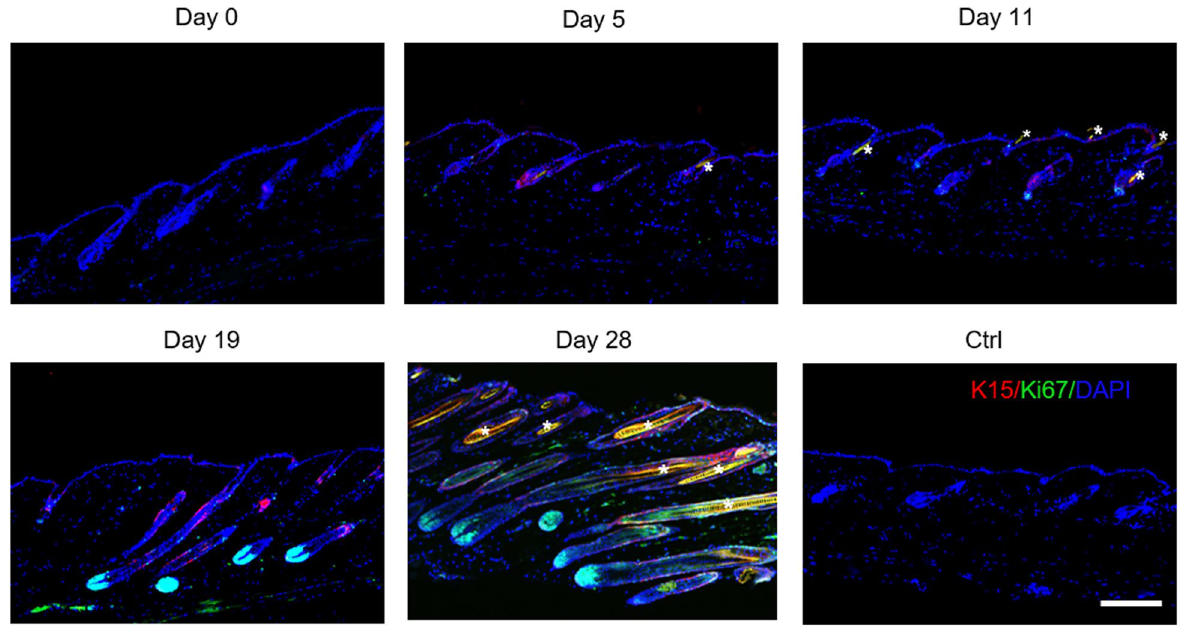
Fig. 5 Hair follicle stem cells activated by MNA treatment. K15/Ki67 double-immunofluorescence staining on days 5, 11, 19 and 28 revealed that the hair follicle stem cells were gradually activated and proliferated after MNA treatment. (Scale bar: 100 μm). *Autofluorescence of hair